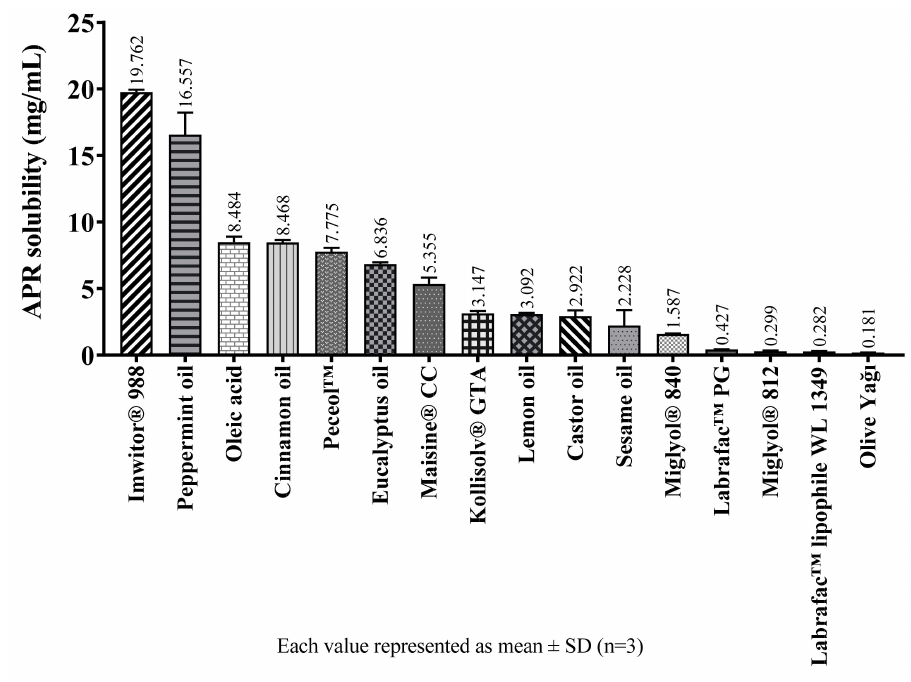
Figure 6. The solubility of APR at 25 ◦ C in oily excipients.